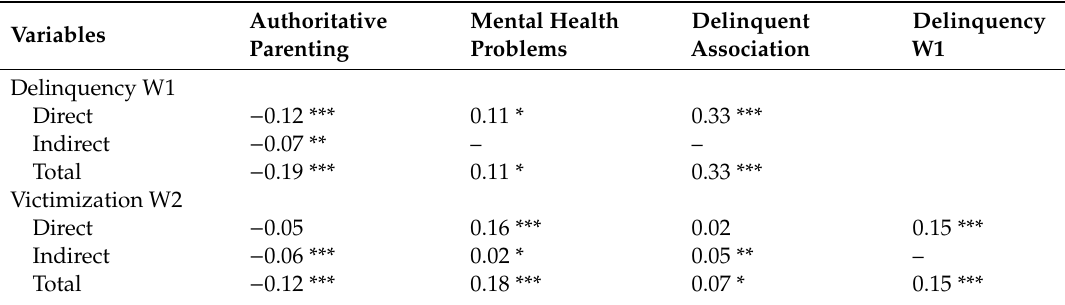
Table 3. Direct, indirect, and total e ff ects of authoritative parenting, mental health problems, and delinquent peer